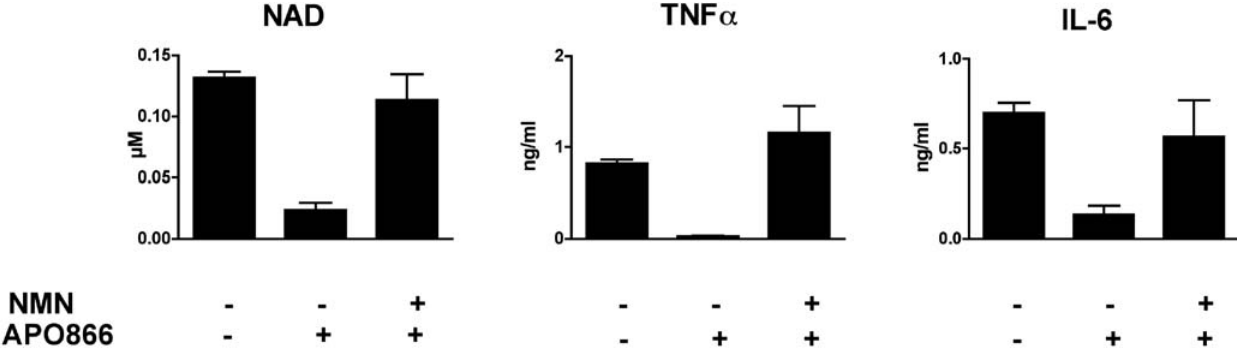
Figure 6. Exogenous nicotinamide mononucleotide, NAMPT-catalyzed reaction end product, reverts the inhibitory effects of APO866. Mouse PEC were incubated in the presence or absence of 200 nM APO866 and 10 mM nicotinamide mononucleotide (NMN). Cells were further stimulated with LPS and intracellular NAD levels and TNF a and IL-6 secretion were determined. Data are mean 6 SEM of triplicates.